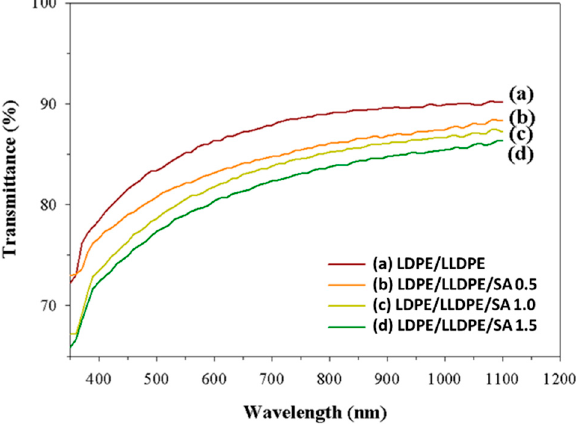
Figure 3. The UV–Vis spectra of the LDPE/LLDPE blend polymer film with various SA contents: (a) 0 wt.%, (b) 0.5 wt.%, (c) 1 wt.%, and (d) 1.5 wt.%.